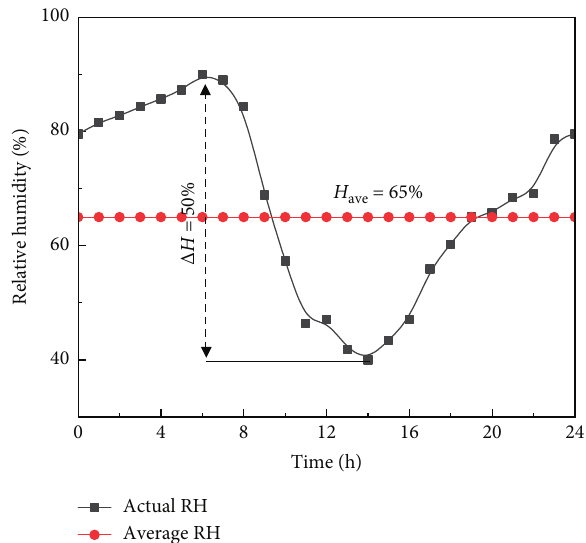
Figure 13: Daily periodic fluctuations of ambient relative humidity applied on the surface of sleeper.